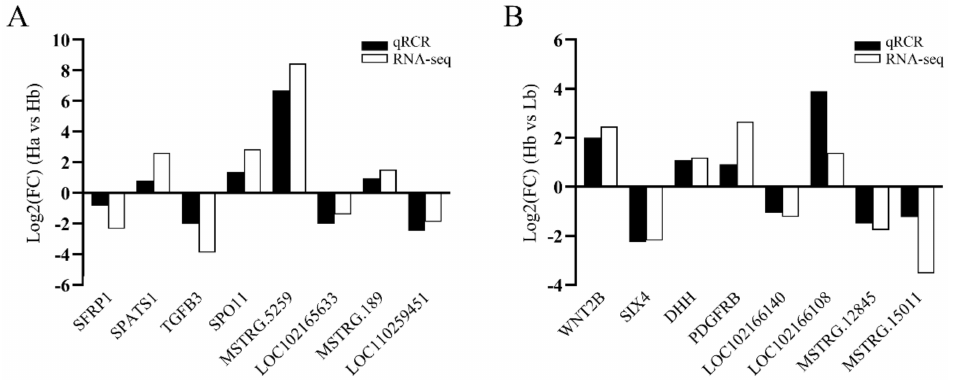
Figure 7. qRT-PCR verification of the differentially expressed genes: ( A ) The qRT-PCR verification of the differentially expressed genes in Ha vs Hb; ( B ) the qRT-PCR verification of the differentially expressed genes in Hb vs